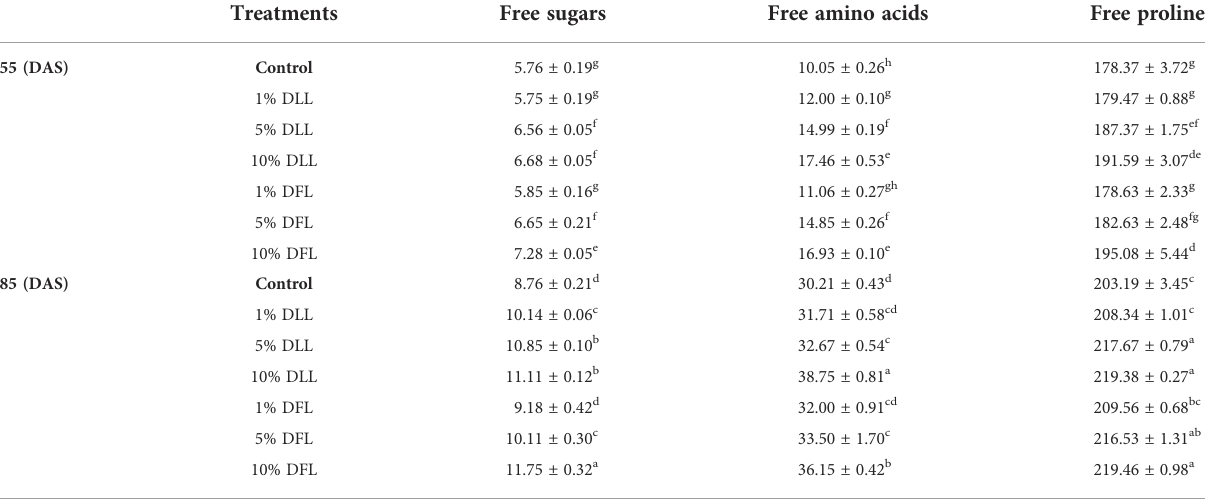
TABLE 7 Free sugars, free amino acids (mg g -1 dr wt), and free proline ( m mole g -1 dr wt) contents in fl ag leaves of Triticum aestivum L. raised using soil substrate at different developmental stages treated with leachates of dry leaves and fl owers of Tagetes erecta L.